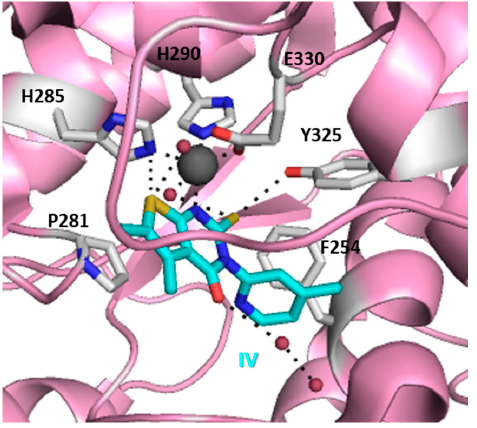
Figure 1. Close view of the PAH catalytic site showing bound IV PC depicted in cyan (PDB ID 4 ANP [12]). The catalytic iron atom (gray sphere) is five-coordinated. Its interaction with N1 of IV PC (in CPK with carbon atoms in cyan) does not perturb its coordination with the residues of the catalytic triad: H285, H290 and E330. Additional compound interactions with water molecules (small red spheres) and PAH residues (in CPK) are also represented.